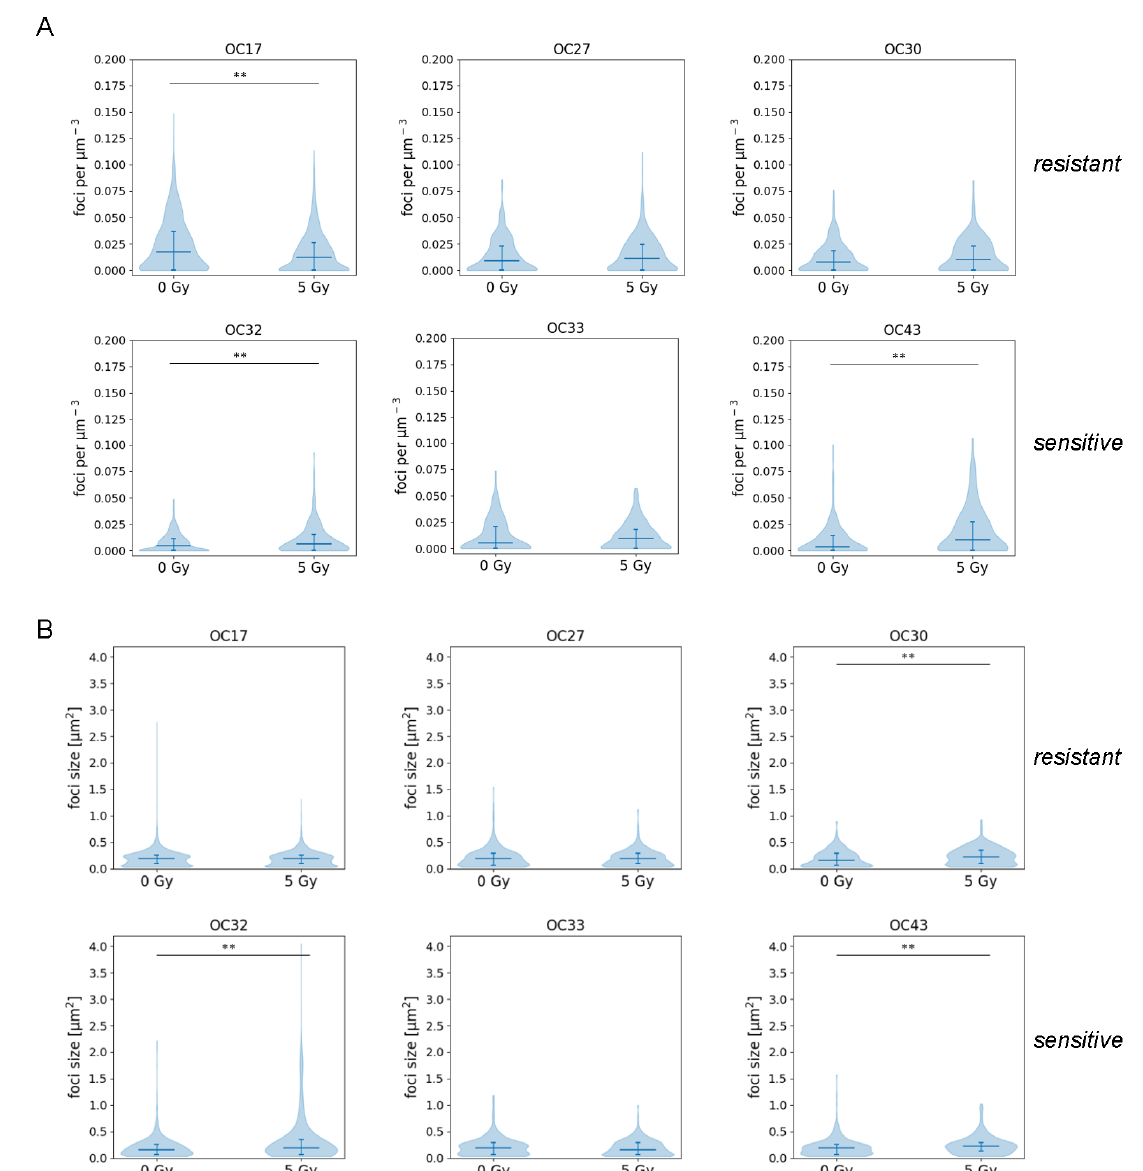
Figure 4. IR-sensitive HNSCC tumors show more unresolved DNA damage. ( A ) 53BP1 foci count per nuclear volume in the IR-resistant and -sensitive samples. Violin plots represent all scored nuclei, the horizontal line depicts the median, and error bars show the interquartile range. ( B ) 53BP1 foci size in the IR-resistant and -sensitive samples. Violin plots represent all scored foci, the horizontal line depicts the median, and error bars show the interquartile range. Differences were tested with the Kruskal–Wallis test. ** p <